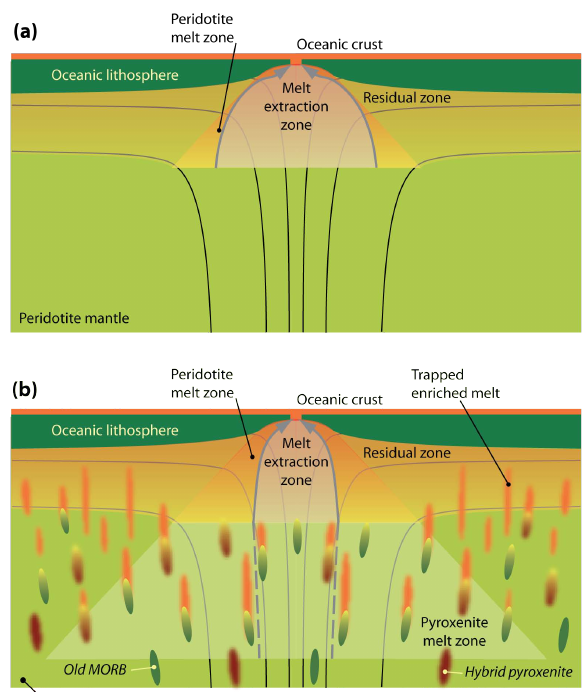
Fig. 15. Sketches of melting under a mid-ocean ridge. (a) As- suming a homogeneous source. The curves are flow lines of the solid mantle. (b) Assuming a heterogeneous source. Old subducted oceanic crust (Old MORB) in the eclogite assemblage will start melting at a greater depth than peridotite. Some of the resulting melt may fail to be extracted, and remain as hybrid pyroxenite. Multiple generations of hybrid pyroxenite may return to the melting zone. After Davies (2009b). Copyright American Geophysical